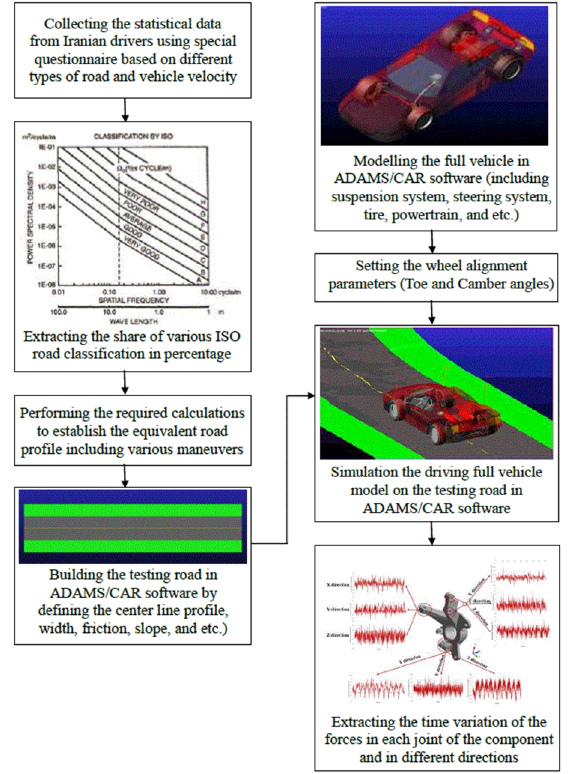
Figure 5. The practical algorithm of force-time histories extraction process based on the multi-body dynamics simulation [55,56].